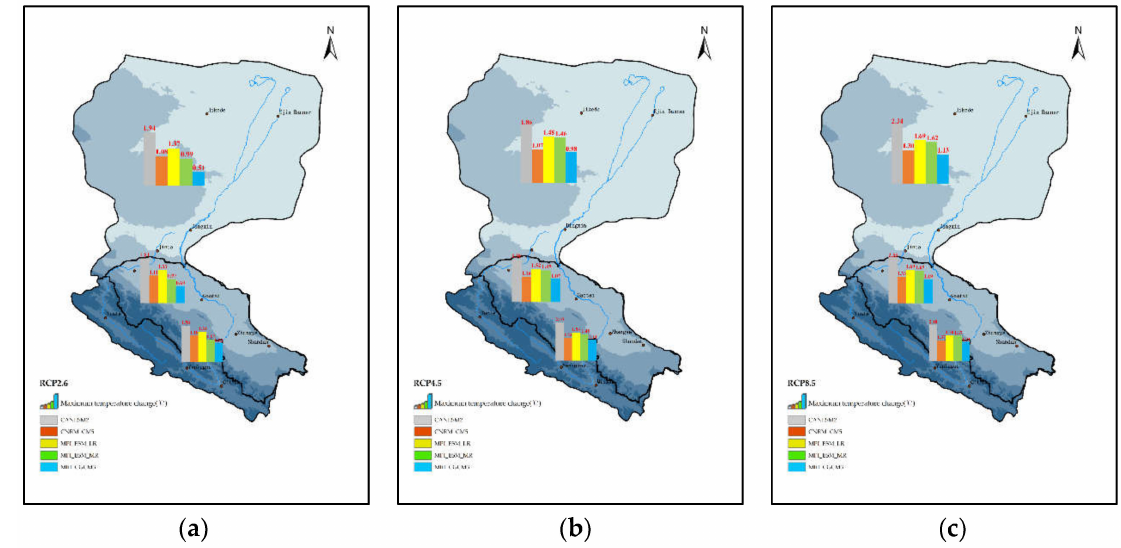
Figure 7. Multi-model projected spatial variations in maximum air temperature in ( a ) RCP2.6; ( b ) RCP4.5; ( c )